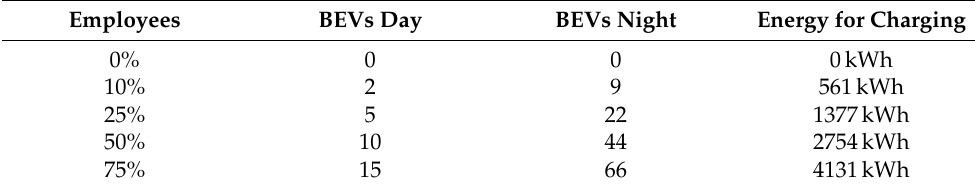
Table 3. Scenarios